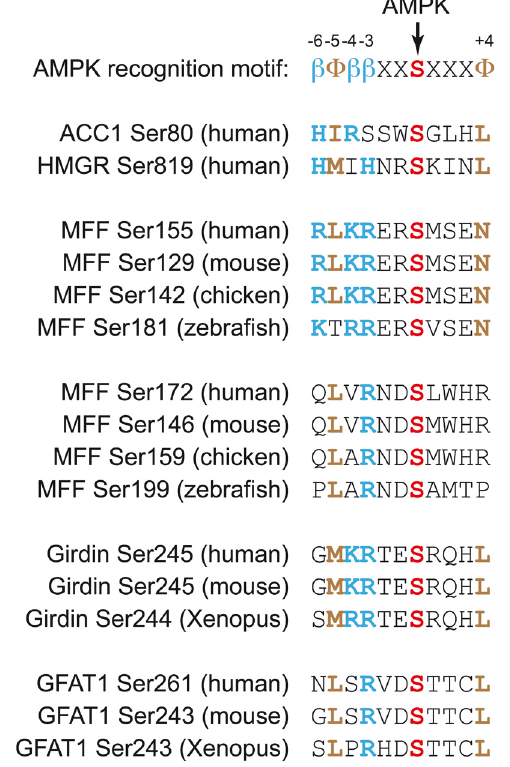
tein-1 (DRP1), which is recruited to mitochondria in part by the mitochondrial fission factor (MFF). The latter is phosphorylated